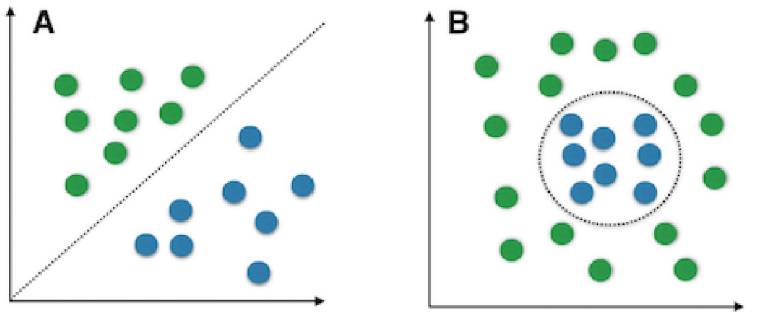
Fig 22. Linear (left) and nonlinear (right) data types [69].